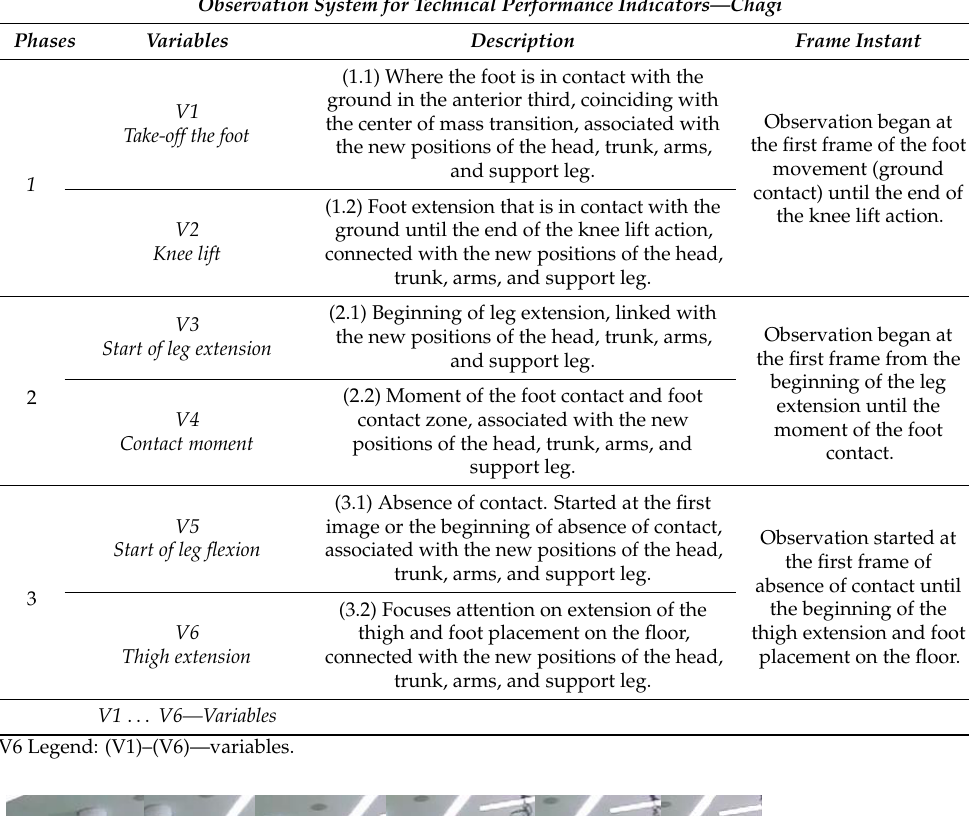
Table 9. OSTIP-C Observation Instrument.